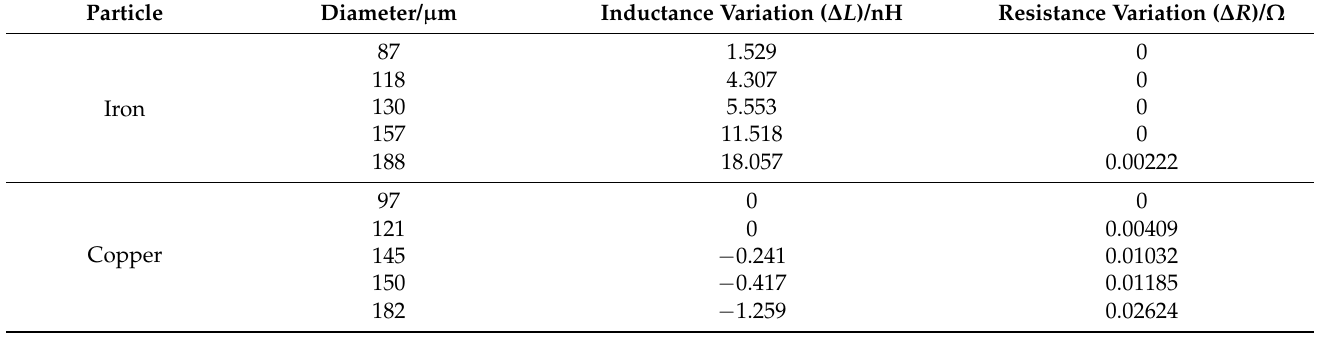
Table 1. The impedance variation induced by iron and copper particles.